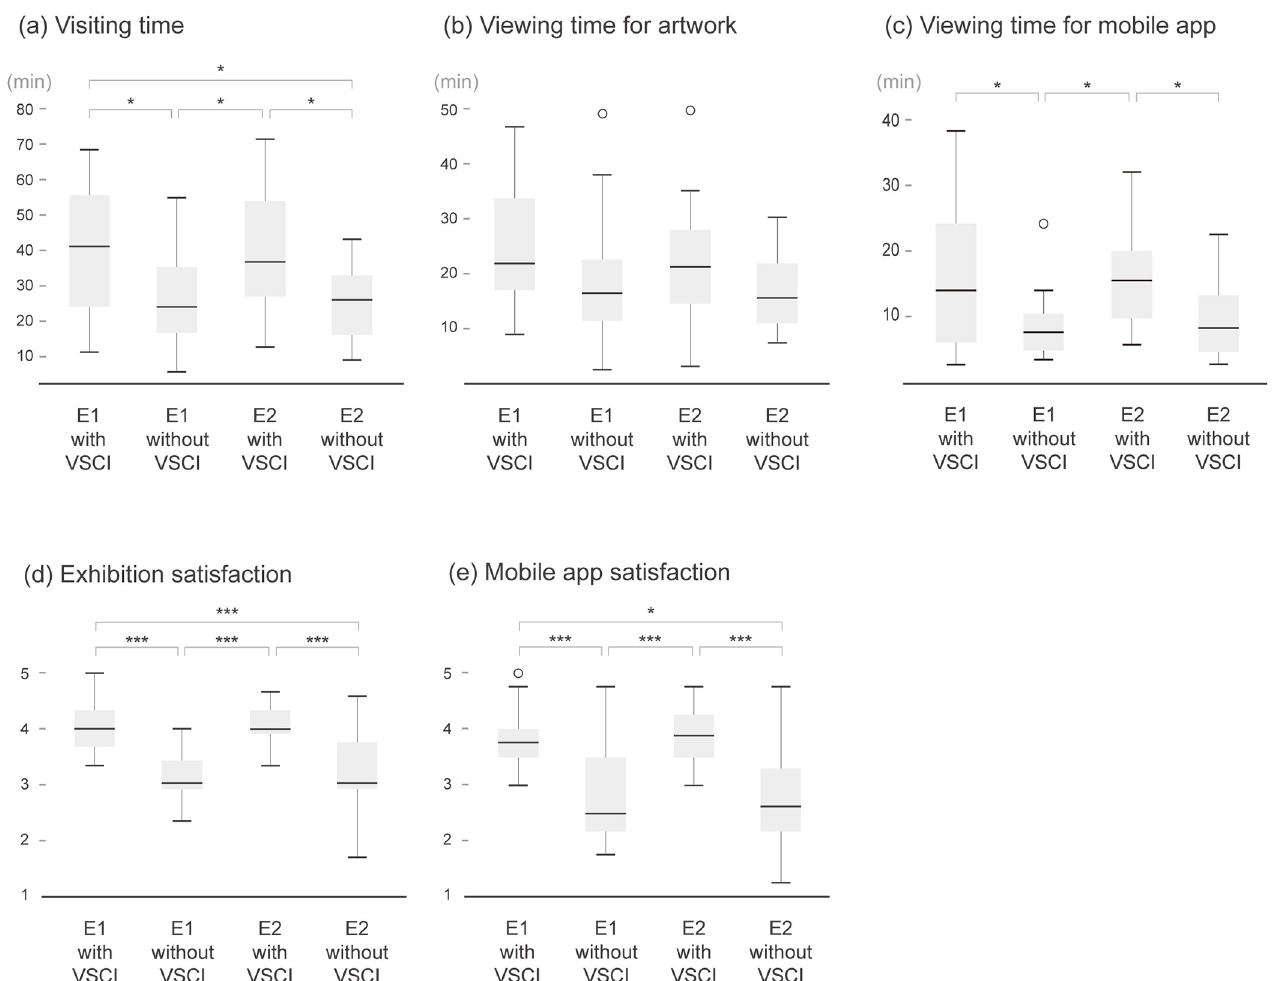
Fig 7. Box-and-whisker plots of the four conditions for visitor behavior (A to C) and satisfaction (D, E). The results of multiple comparison corrections by Tukey HSD between groups are presented ( � denotes p < 0.05; �� , p < 0.01, and ��� , p < 0.001). E1 = first exhibition, E2 = second exhibition, and VSCI = visitor- based social contextual